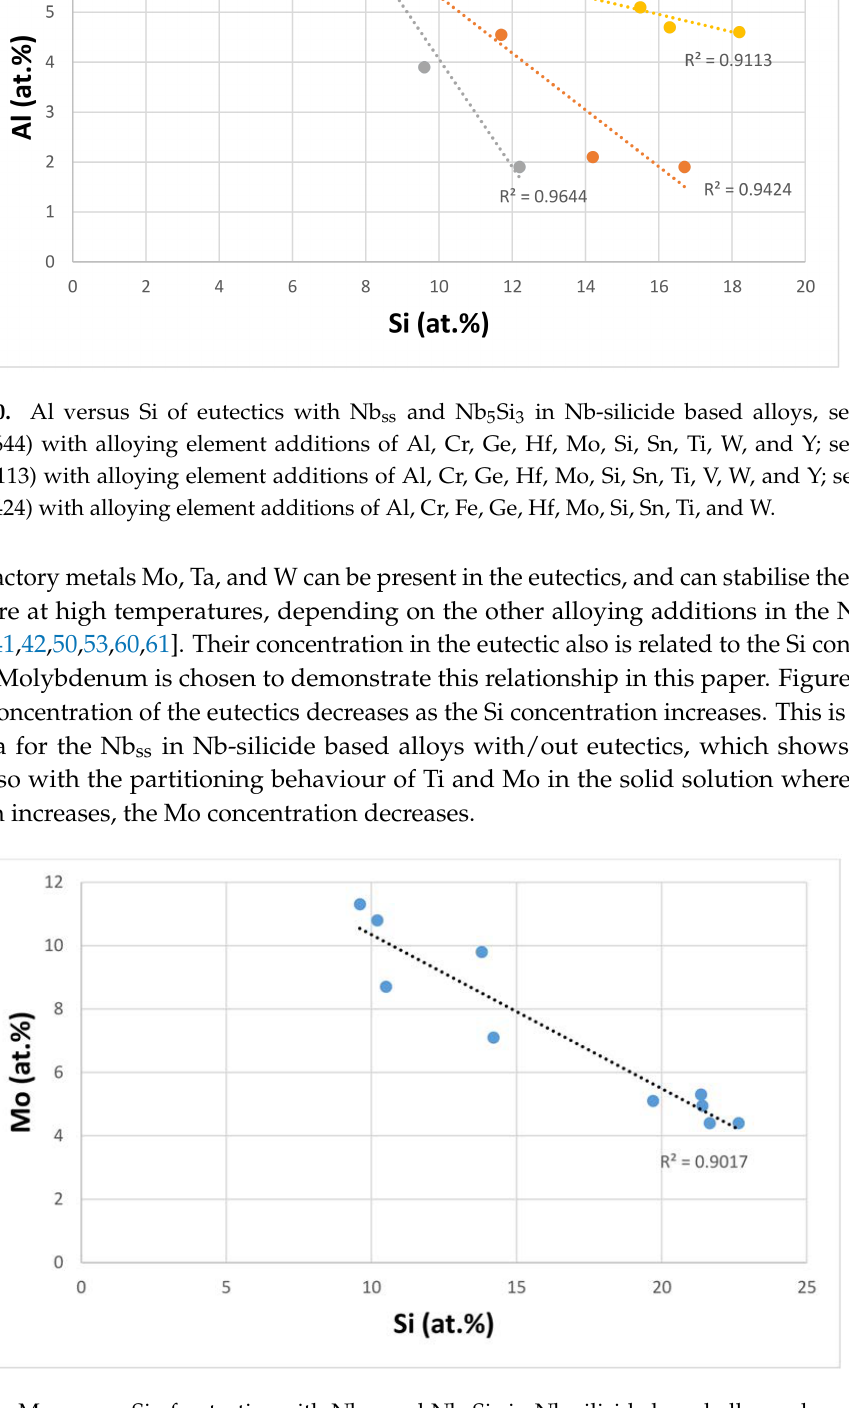
Figure 11. Mo versus Si of eutectics with Nb ss and Nb 5 Si 3 in Nb-silicide based alloys, elements in eutectics: Al, Cr, Ge, Hf, Mo, Nb, Si, Sn, Ti, and